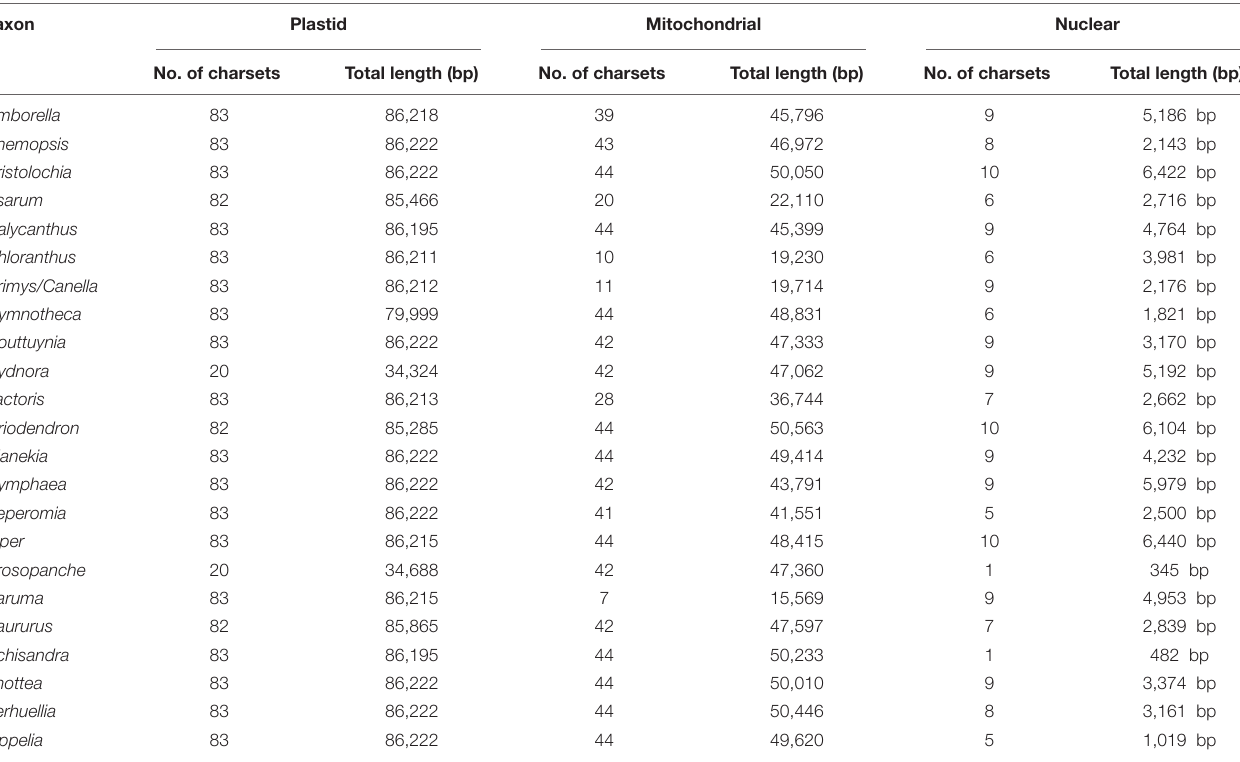
TABLE 1 | Overview of the number of character sets (charsets) and total sequence length (bp) recovered for the three subcellular genomes for all individual accessions represented in the sampling (see Supplementary Table 1 for more details). Taxon Plastid